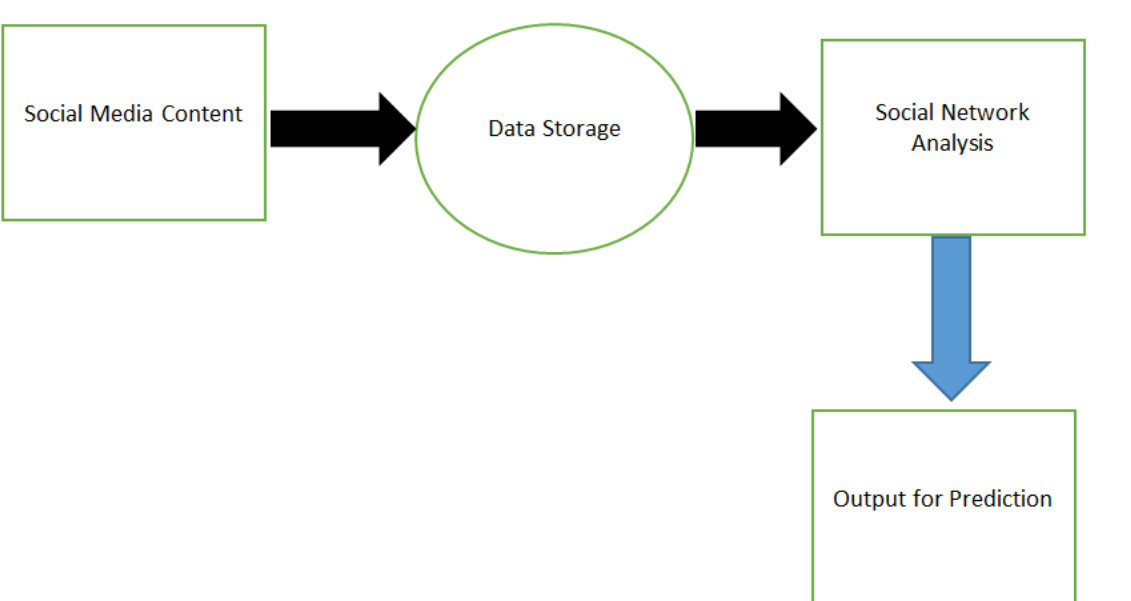
Figure 1. The workflow developed for making sense of Social Media